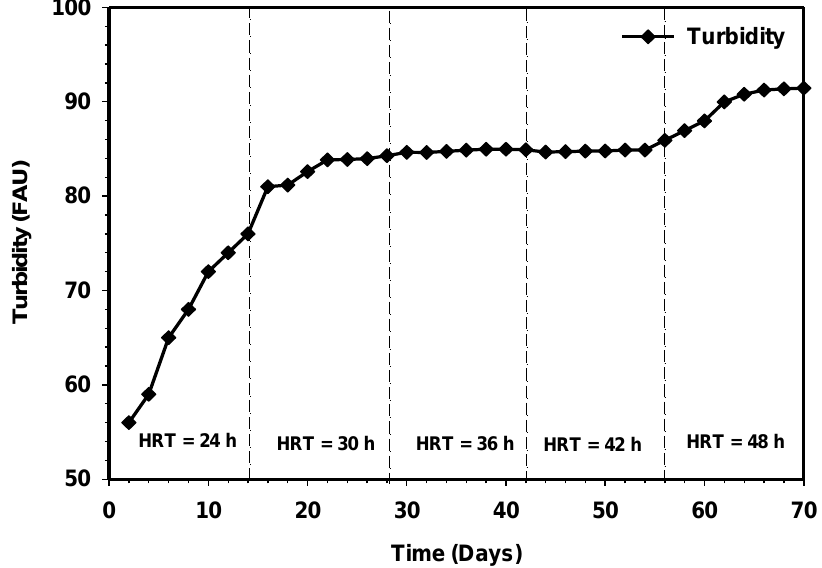
Figure 13. Variation in turbidity relative to increasing contact time.